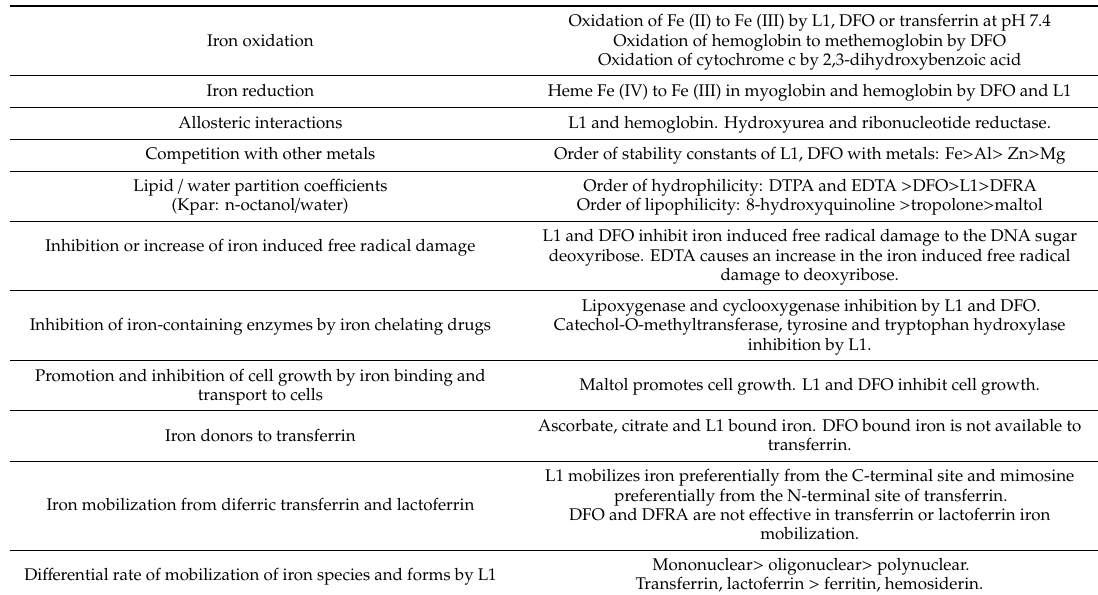
Table 4. Molecular interactions and general e ff ects of iron chelators in vitro.